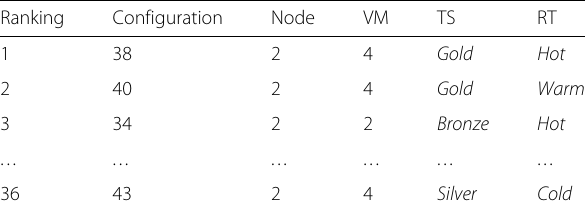
configurations (First case) Ranking